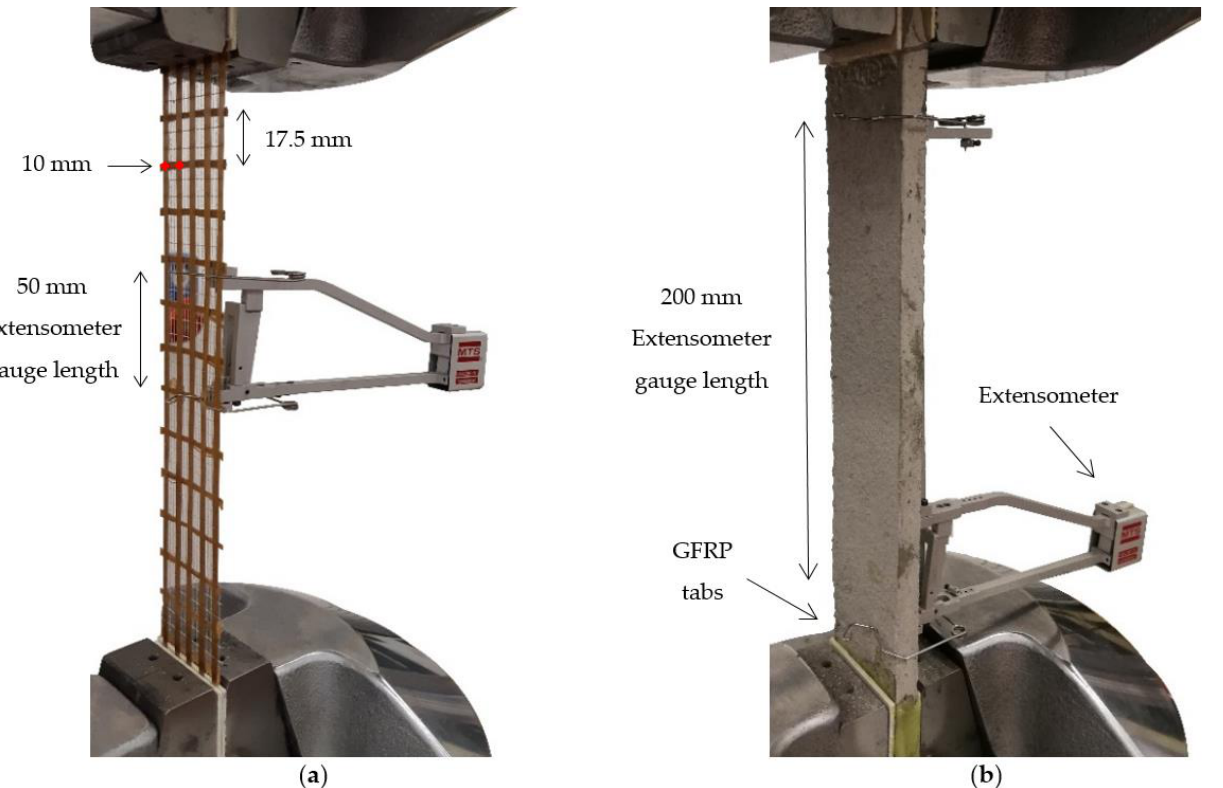
Figure 1. Materials characterization: ( a ) tensile test on bare textile; ( b ) clamping-grip tensile test on FRCM specimen.